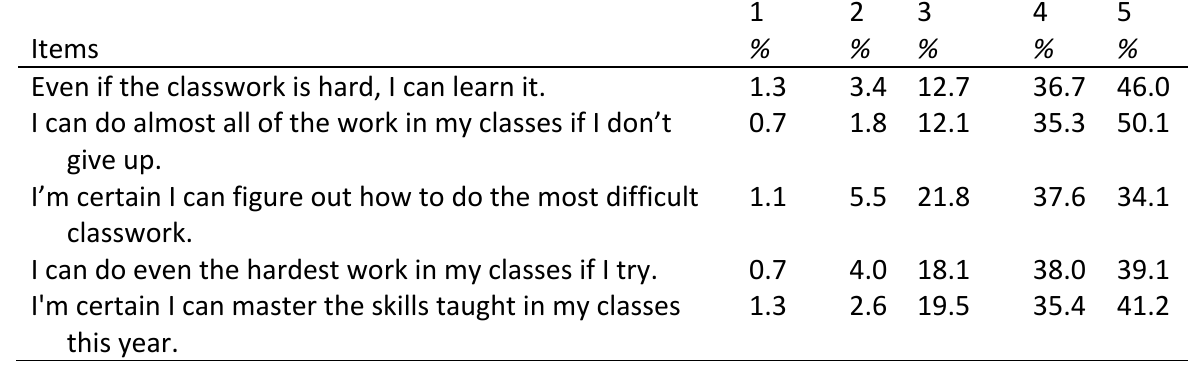
Summary of Student Responses on the Academic Efficacy